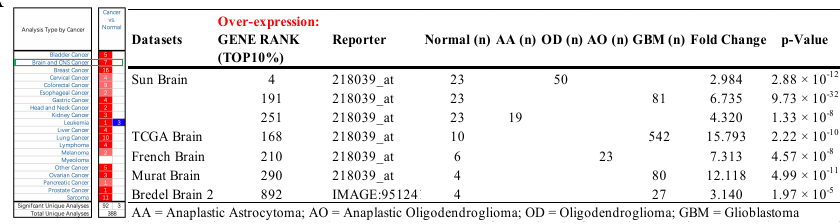
− High(N = 35) Low(N = 39) HR: 1.85[1.25-2.74] p = 0.001303